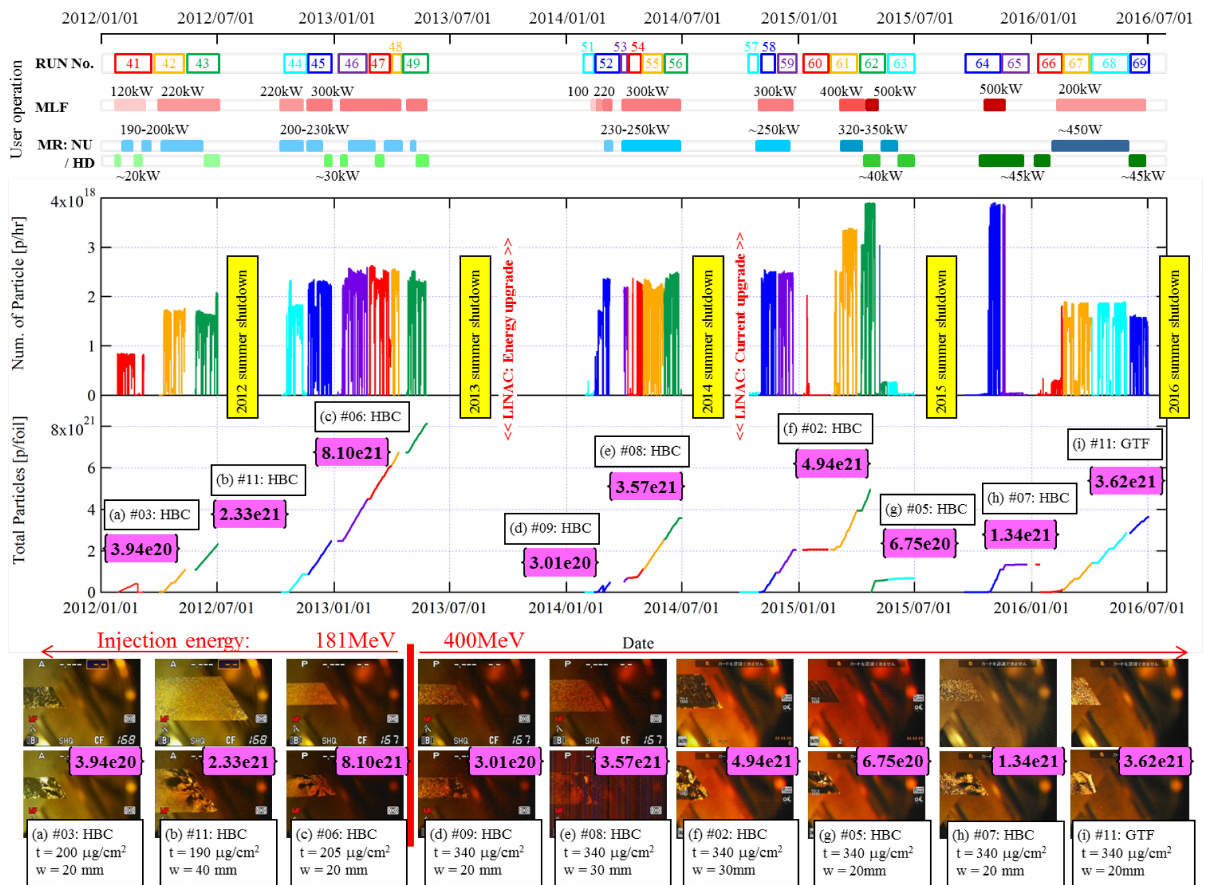
Fig. 1. History of beam power increase and stripper foil usage in the J-PARC RCS from 2011 to 2016.